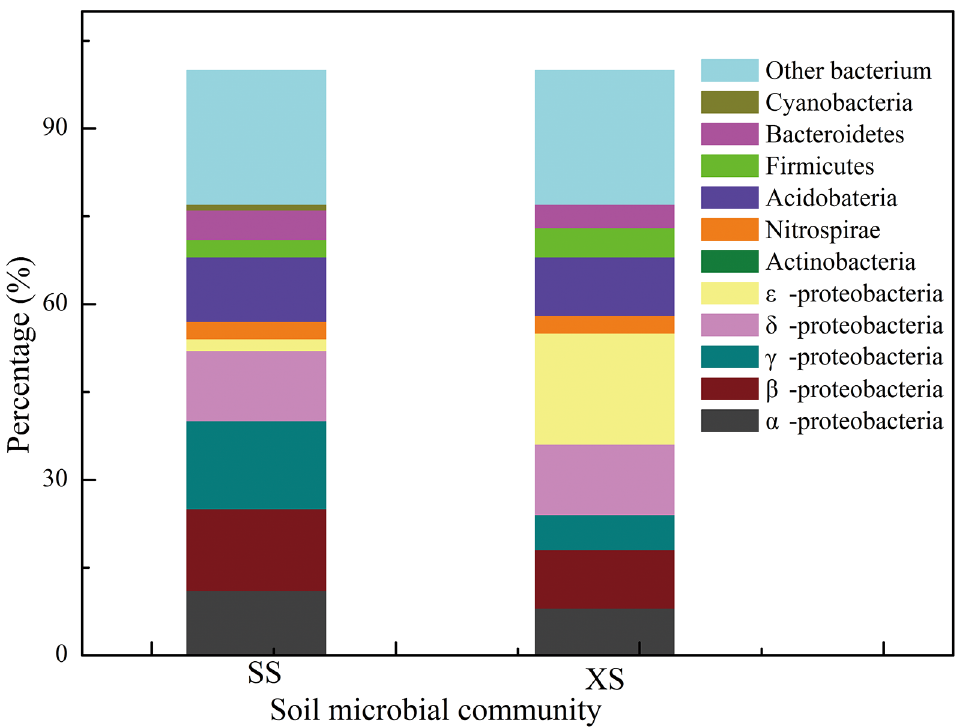
Fig 4. Prevalence of different phylogenetic groups of bacteria in Shang shoals and Xia shoals. S: Shang shoal, X: Xia shoal. Based on the data from S2 and S3 Tables, see SI.